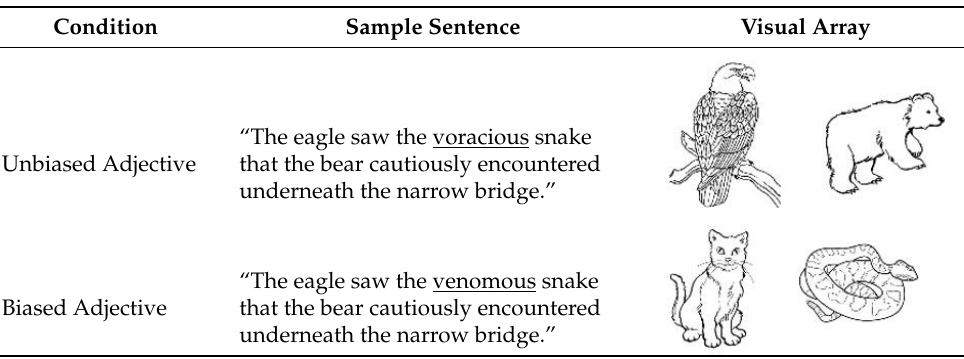
Table 3. Example of experimental sentence and visual stimuli.